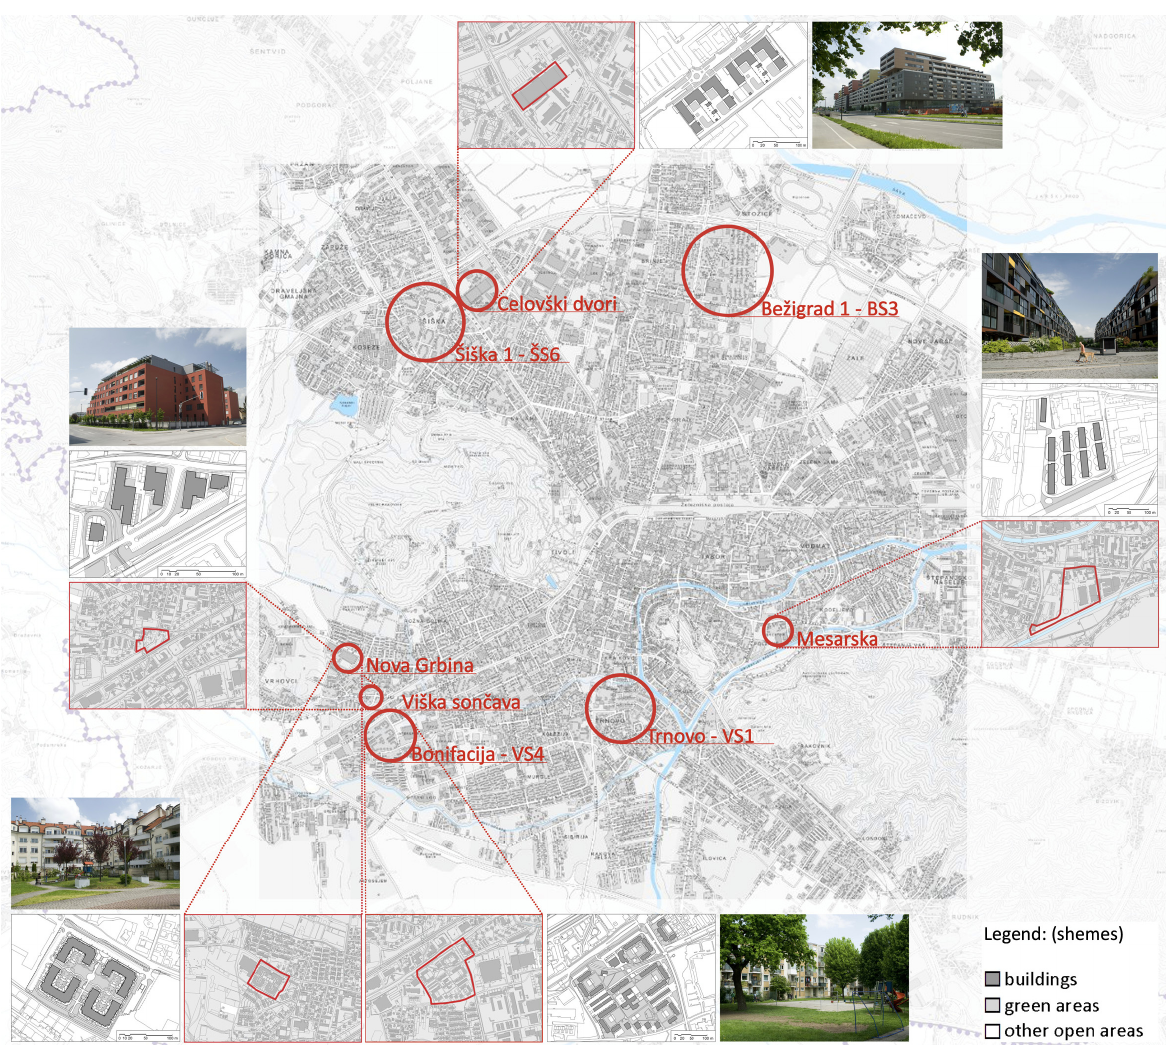
Viška son č ava, Bonifacija, Mesarska in Celovški dvori), are also illustrated in diagrams showing area outline, a schematic map with the map key, and a photo of the